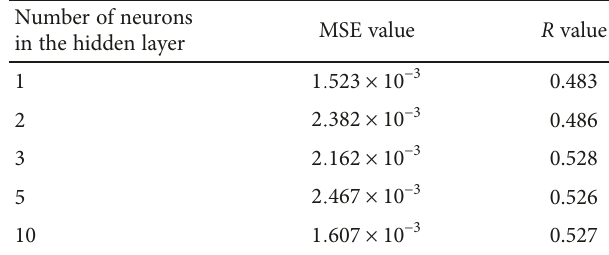
Table 2: Values of MSE and R depending on the number of neurons in the hidden layer in model ANN 1.